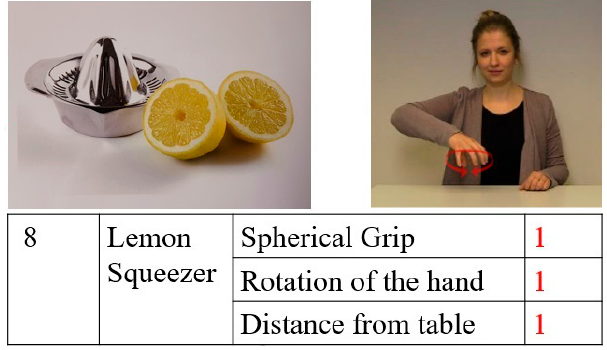
Figure A3 . Example Scoring Pantomime task